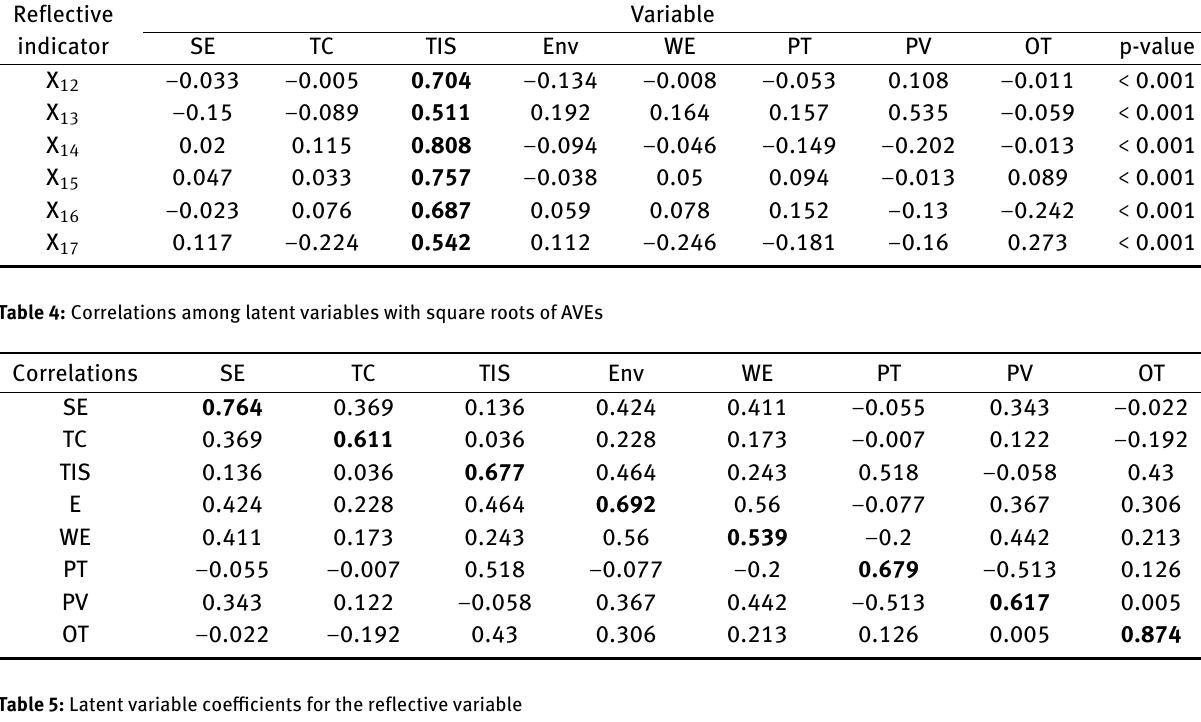
Table 3: Loadings and cross loadings values for the test of the validity of reflective indicators Reflective